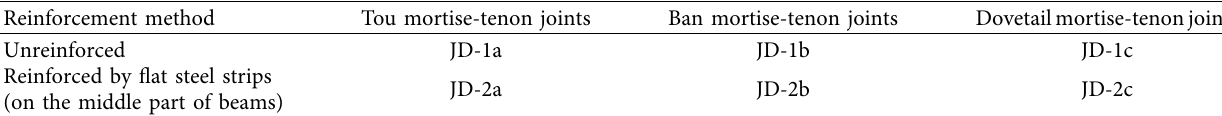
Table 2: Reinforcement method of joints.